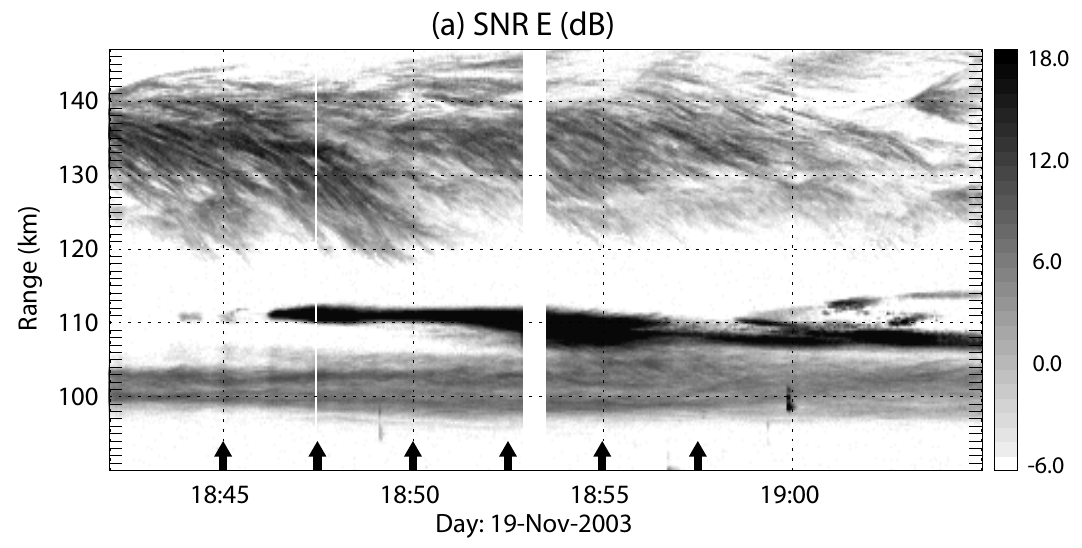
Fig. 3. Range-time intensity plot of the EEJ echoes observed on 19 November 2003 using an aperture synthesis imaging mode. The vertical arrows indicate where the snapshots shown below were